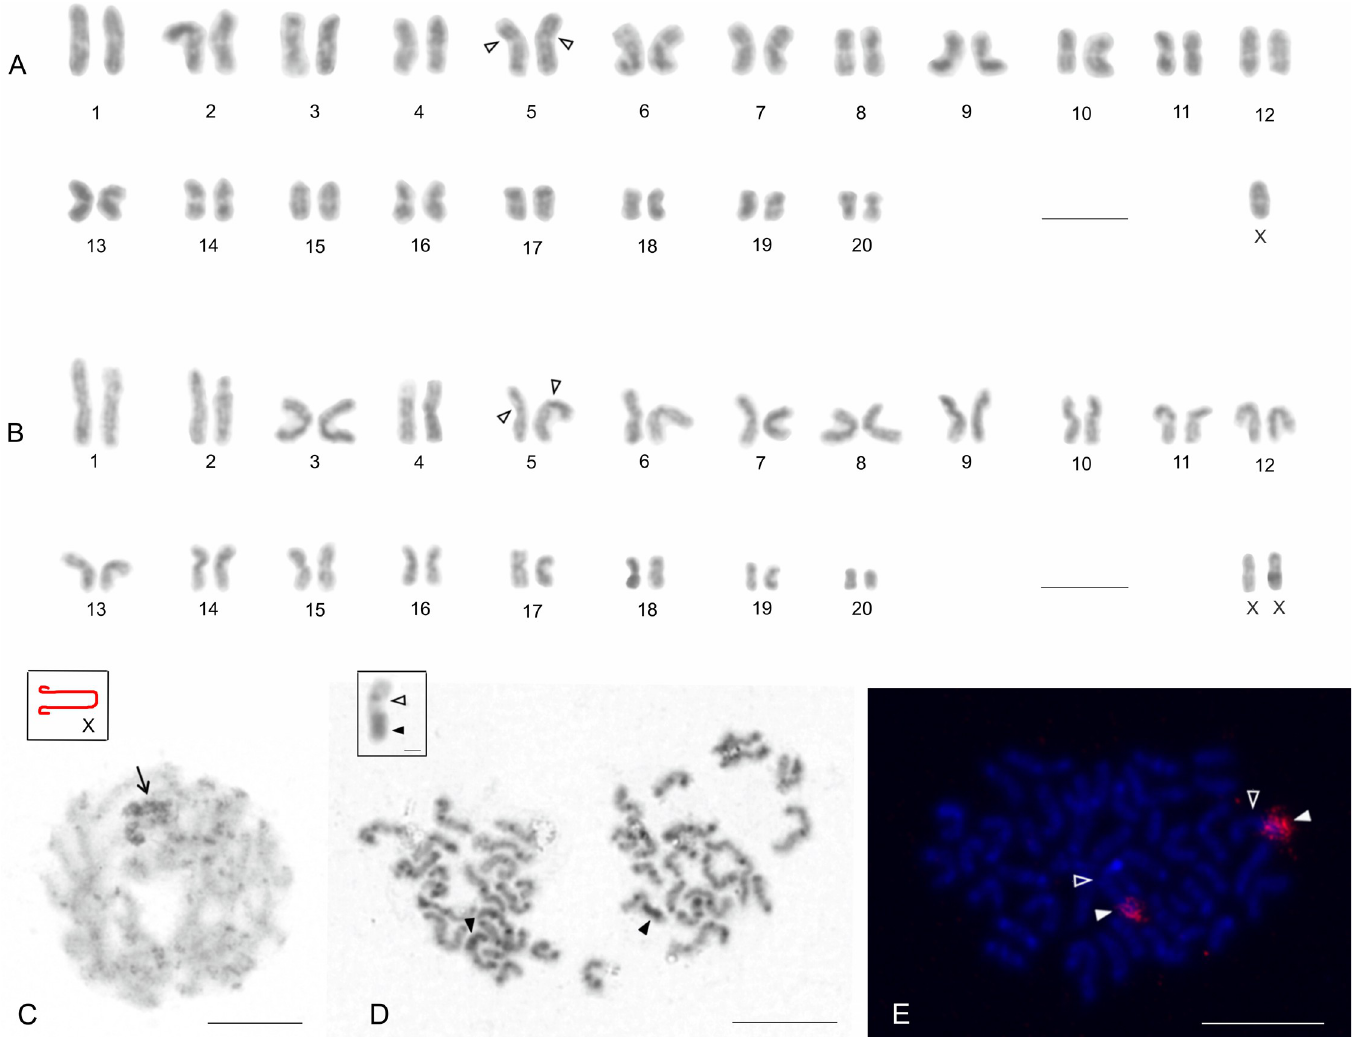
Fig 2. Chromosomes of A . karschi , Pennsylvania, USA. A, B. Male (A) and female karyotypes (B), stained by Giemsa, based on mitotic metaphase. 2n ♂ = 41, X0; 2n ♀ = 42, XX. Empty arrowhead–centromere of submetacentric pair. C. Male pachytene. Note heterochromatic X chromosome on the periphery of the nucleus and prominent knobs on the bivalents. Inset: Scheme of sex chromosome. Note an association of X chromosome arms. Arrow–sex chromosome. D. Male mitotic metaphase, C-banding. Chromosomes exhibit intercalar and terminal heterochromatin blocks. Inset: Magnified submetacentric chromosome containing a large block of heterochromatin (from another mitotic metaphase). Arrowhead–a large block of heterochromatin, empty arrowhead–centromere. E. Male mitotic metaphase, detection of rDNA cluster (FISH). Note chromosomes of a submetacentric pair containing a terminal rDNA cluster at long arm. Arrowhead–rDNA cluster, empty arrowhead–centromere. Scale bars: 10 μ m.